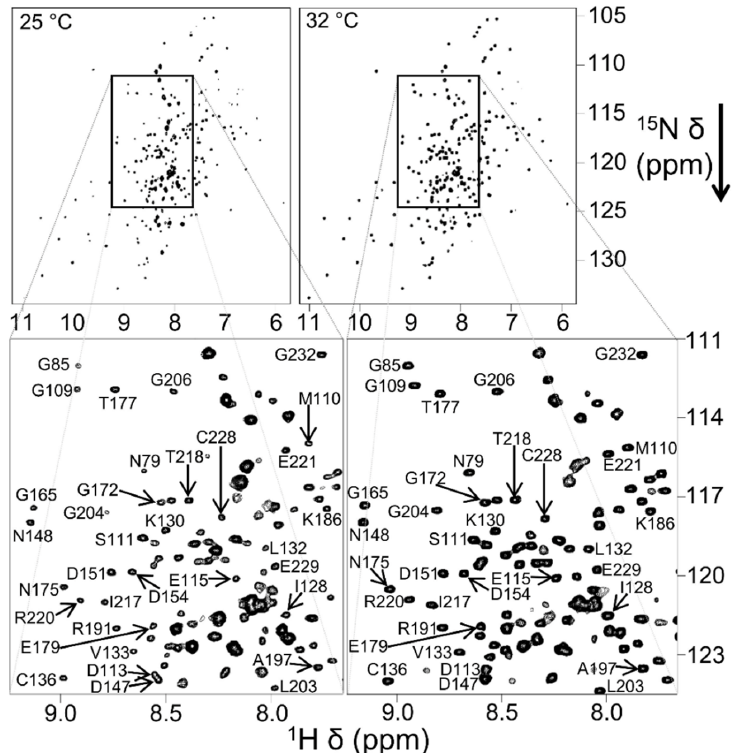
Figure 14. E. coli membrane solubilization by inulin-based non-ionic polymers possessing different types of hydrophobic functional groups (see Figure 2 for the chemical structure). The solubilization efficacy of inulin-based polymers is compared with that of SMA-based polymers and DDM. This Figure and caption are adopted from reference [202] with copyright permission.